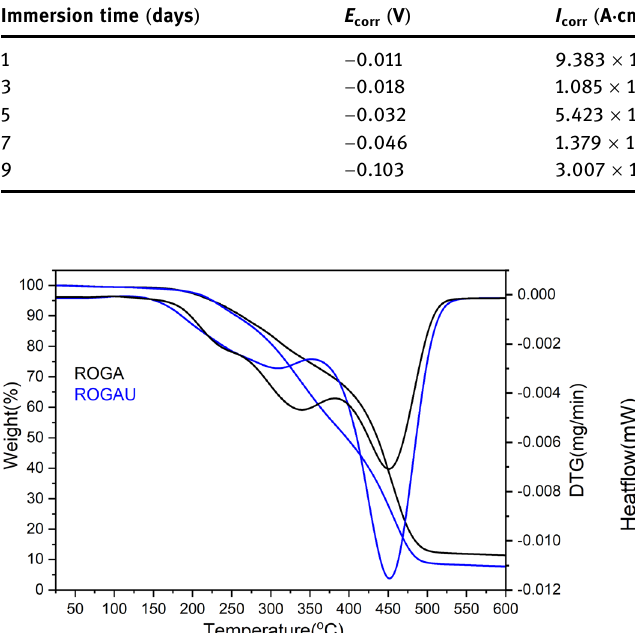
Table 2: The Tafel parameters for ROGAU coating under 3.5 wt% NaCl solution at room temperature Immersion time ( days )